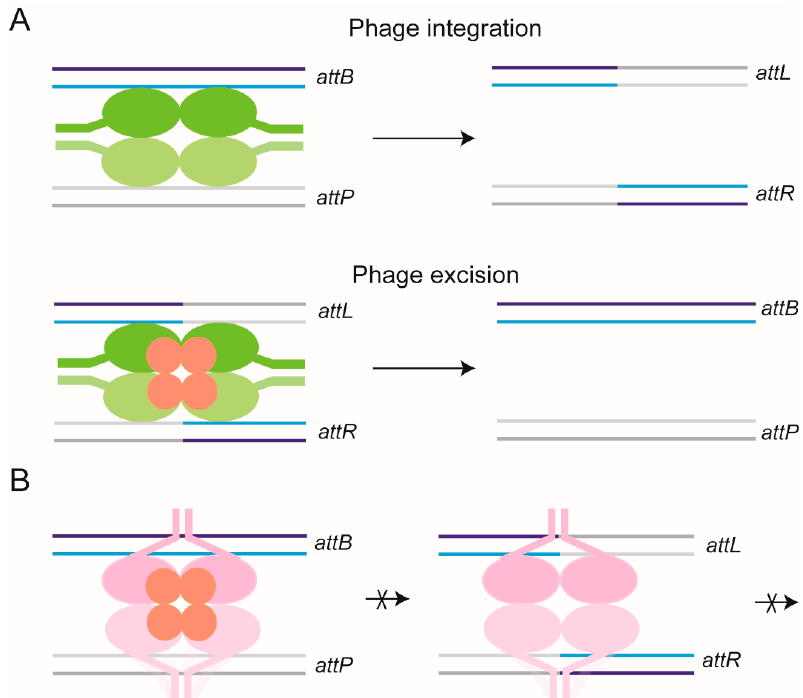
Figure 9. Regulation of directionality during recombination mediated by φ C31 integrase. In the schematic representations of attP × attB and attL × attR recombination reactions, the active and inactive forms of the integrase dimer are colored green and magenta, respectively. The dimers bound to the two target sites are differentiated by their dark and light shades. ( A ) Integrase forms a functional synapse with attP–attB partner sites, and catalyzes recombination between them. In vivo, attP × attB recombination results in the integration of the φ C31 phage into the host chromosome. The prophage is flanked by attL and attR sites. The attL and attR sites are also targets for recombination by the integrase, assisted by the recombination directionality factor (RDF) protein (colored red). ( B ) The attP × attB reaction is inhibited by RDF, while the attL × attR reaction fails to occur in the absence of RDF. The active and inactive configurations of the synapse appear to be regulated by the interactions of the coiled coil (CC) domains present within the carboxyl-terminal portion of integrase. RDF interaction with the DNA-bound integrase apparently induces alternative synaptic configurations for attL–attR sites (active; A ) and attP–attB sites (inactive; B ). The CC domains are drawn as short extensions from the main body of the integrase.